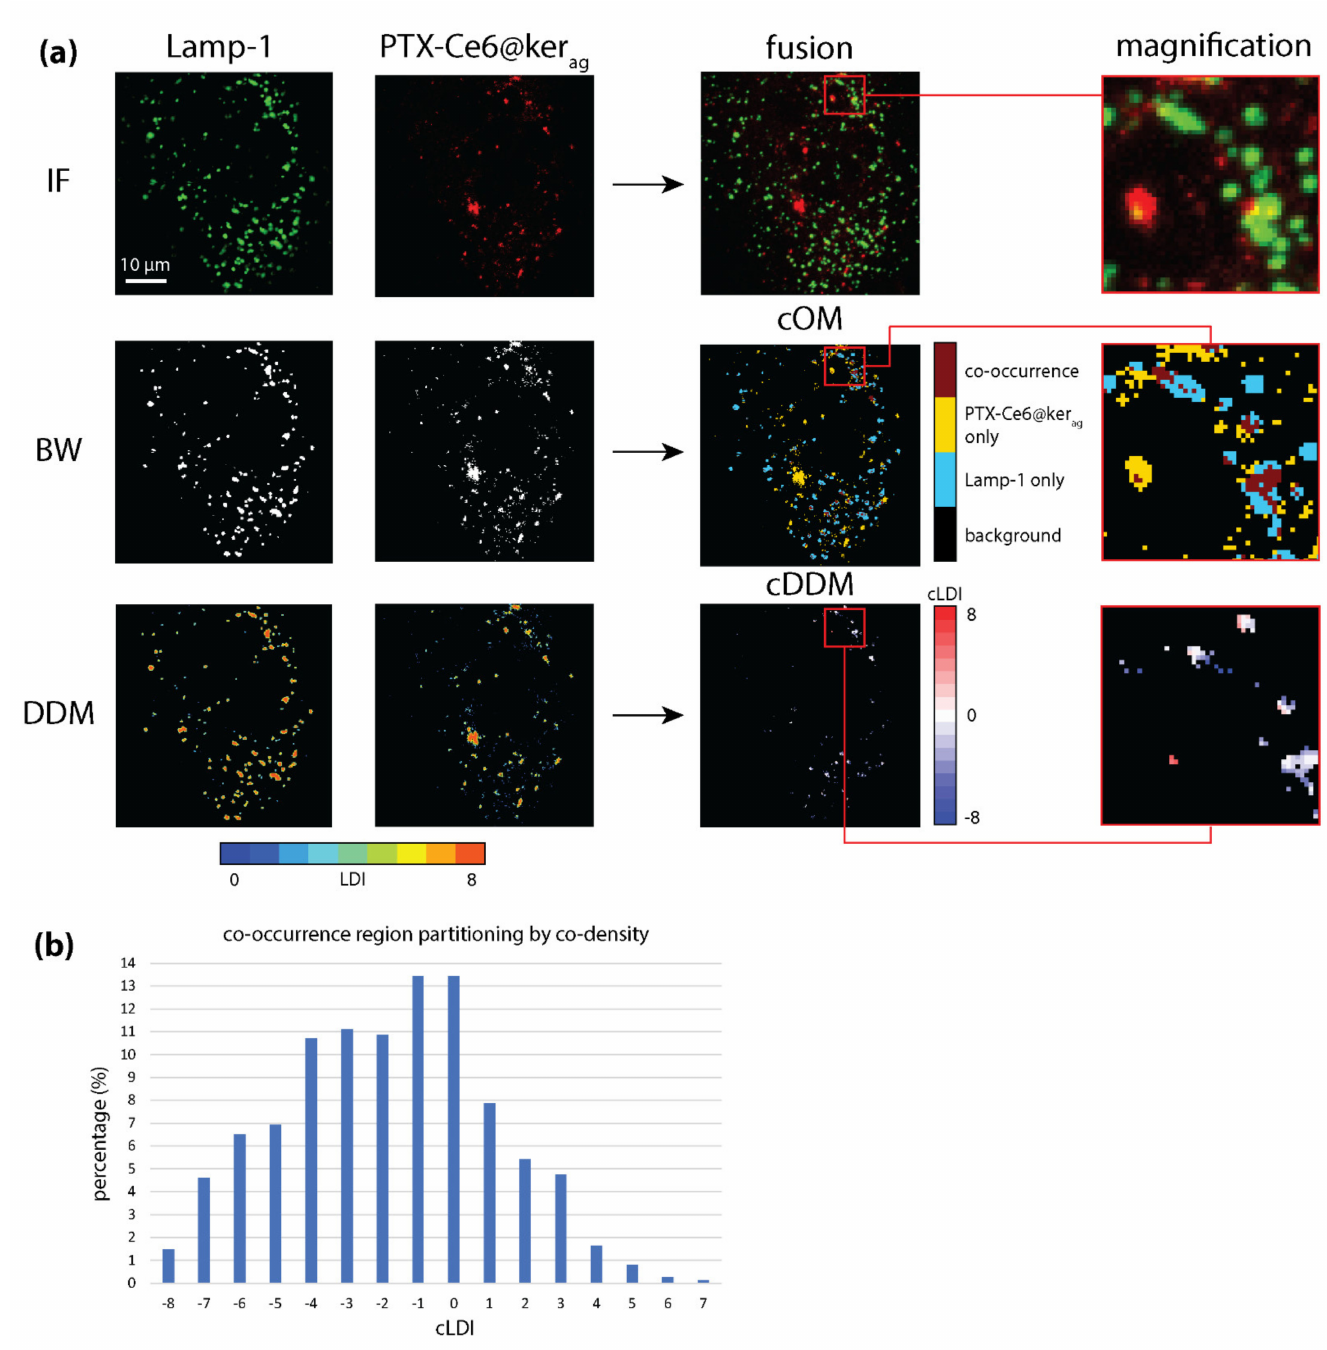
Figure 3. cDDM discloses information about the degree of colocalization. ( a ) Top: Exemplificative immunofluorescence (IF) images of MG-63 cells exposed to PTX-Ce6@ker ag nanoparticles, marked against late endosomes (Lamp-1), with Ce6 (NPs), or both (fusion). Middle: Lamp-1 and Ce6 signals’ binary masks (BW), whose combination produce the co-occurrence map (cOM). Bottom: Lamp-1 and Ce6 DDMs and cDDM. ( b ) Bar graph of co-occurrence region partitioning by co-density, showing a prevalence of negative cLDI values that indicate NPs as generally denser than late